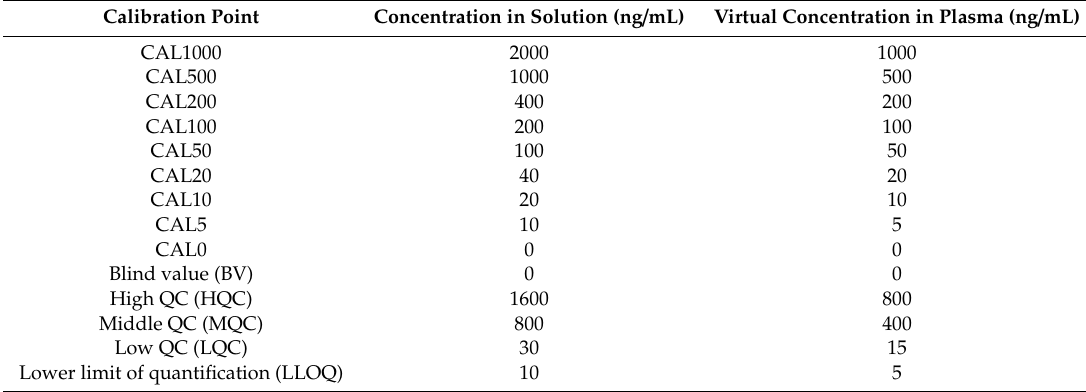
Table 1. Concentrations of the Calibration Standard (CAL) and Quality Control (QC) Samples of Osimertinib in Solution and in Spiked